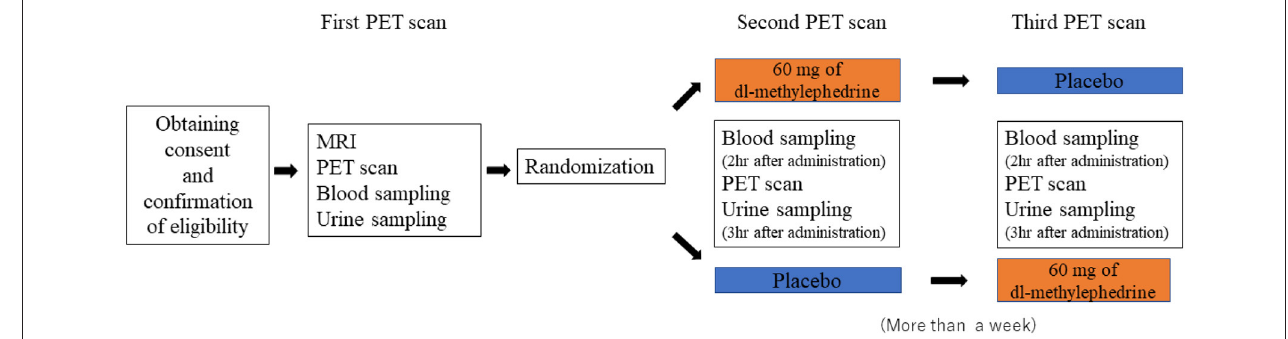
FIGURE 1 | The experimental design of the